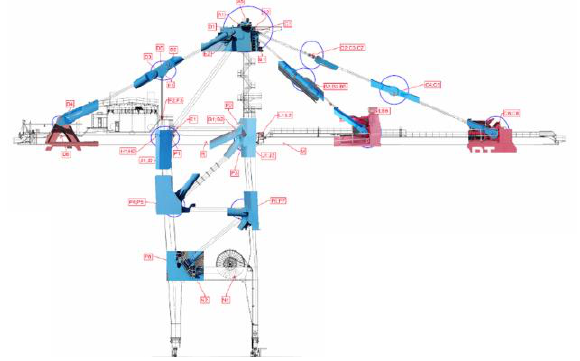
Figure 8. Schematic representation of one crane with 13 critical/neuralgic points